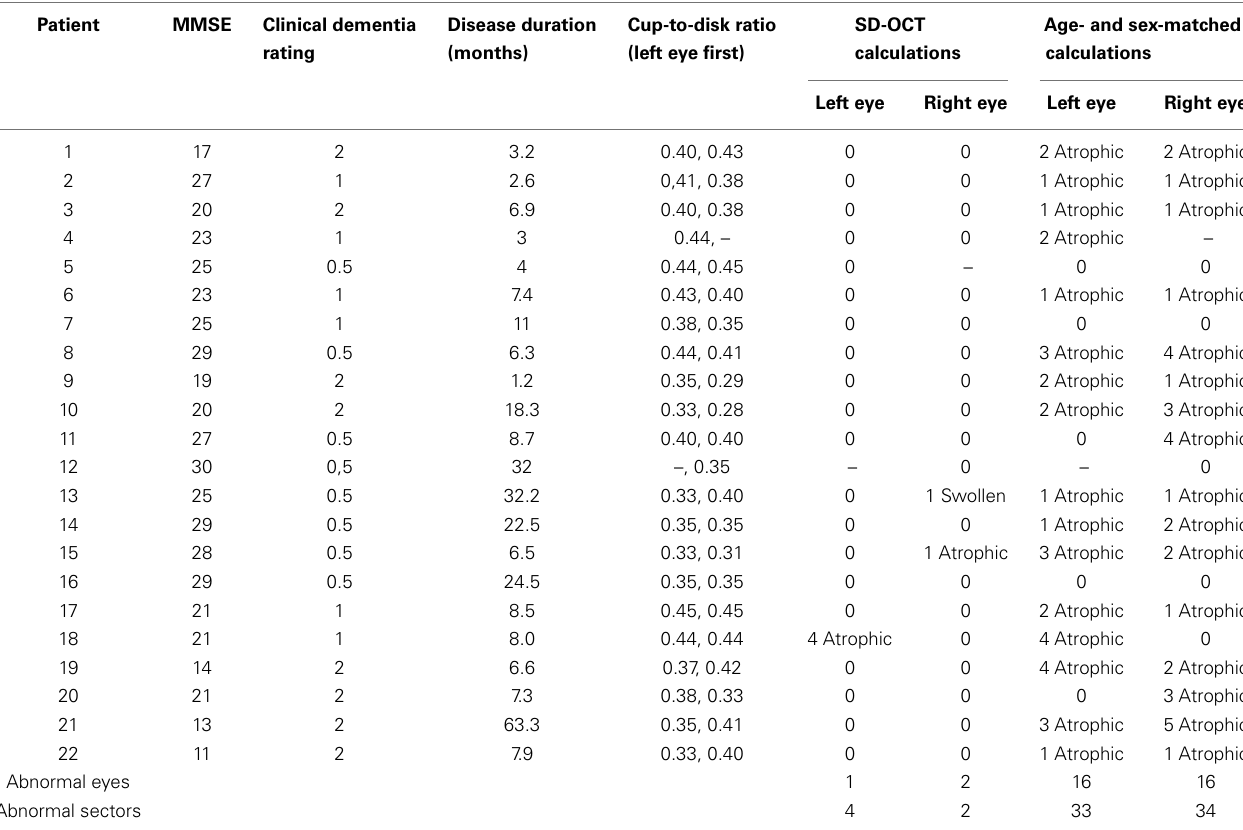
Table 3 | Comparison of the different sectors around the optic disk regarding the retinal nerve fiber layer thickness (RNFLT) in the eyes ofAD